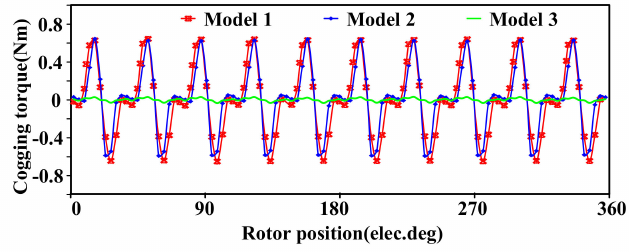
Figure 11. Cogging torque of the three models.